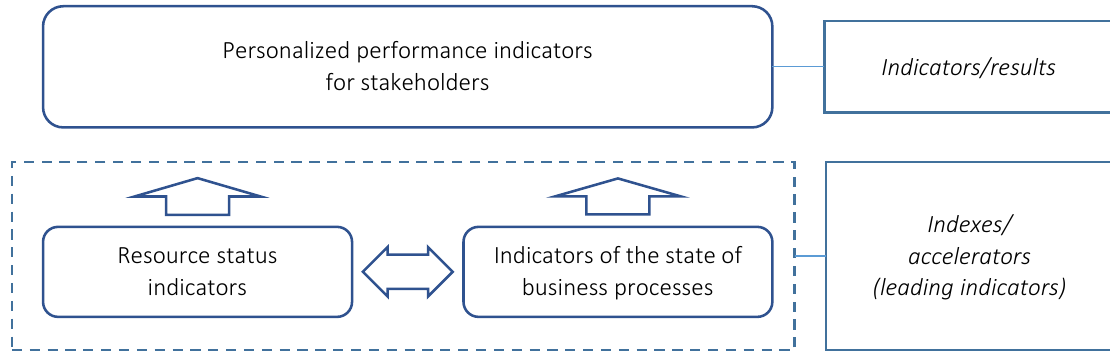
Figure 2. Pyramid of SRPR